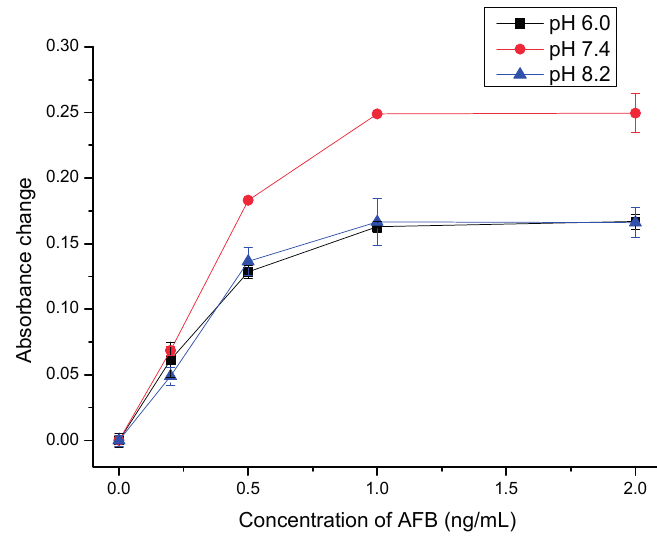
Figure 4. Optimization of pH value for the detection of